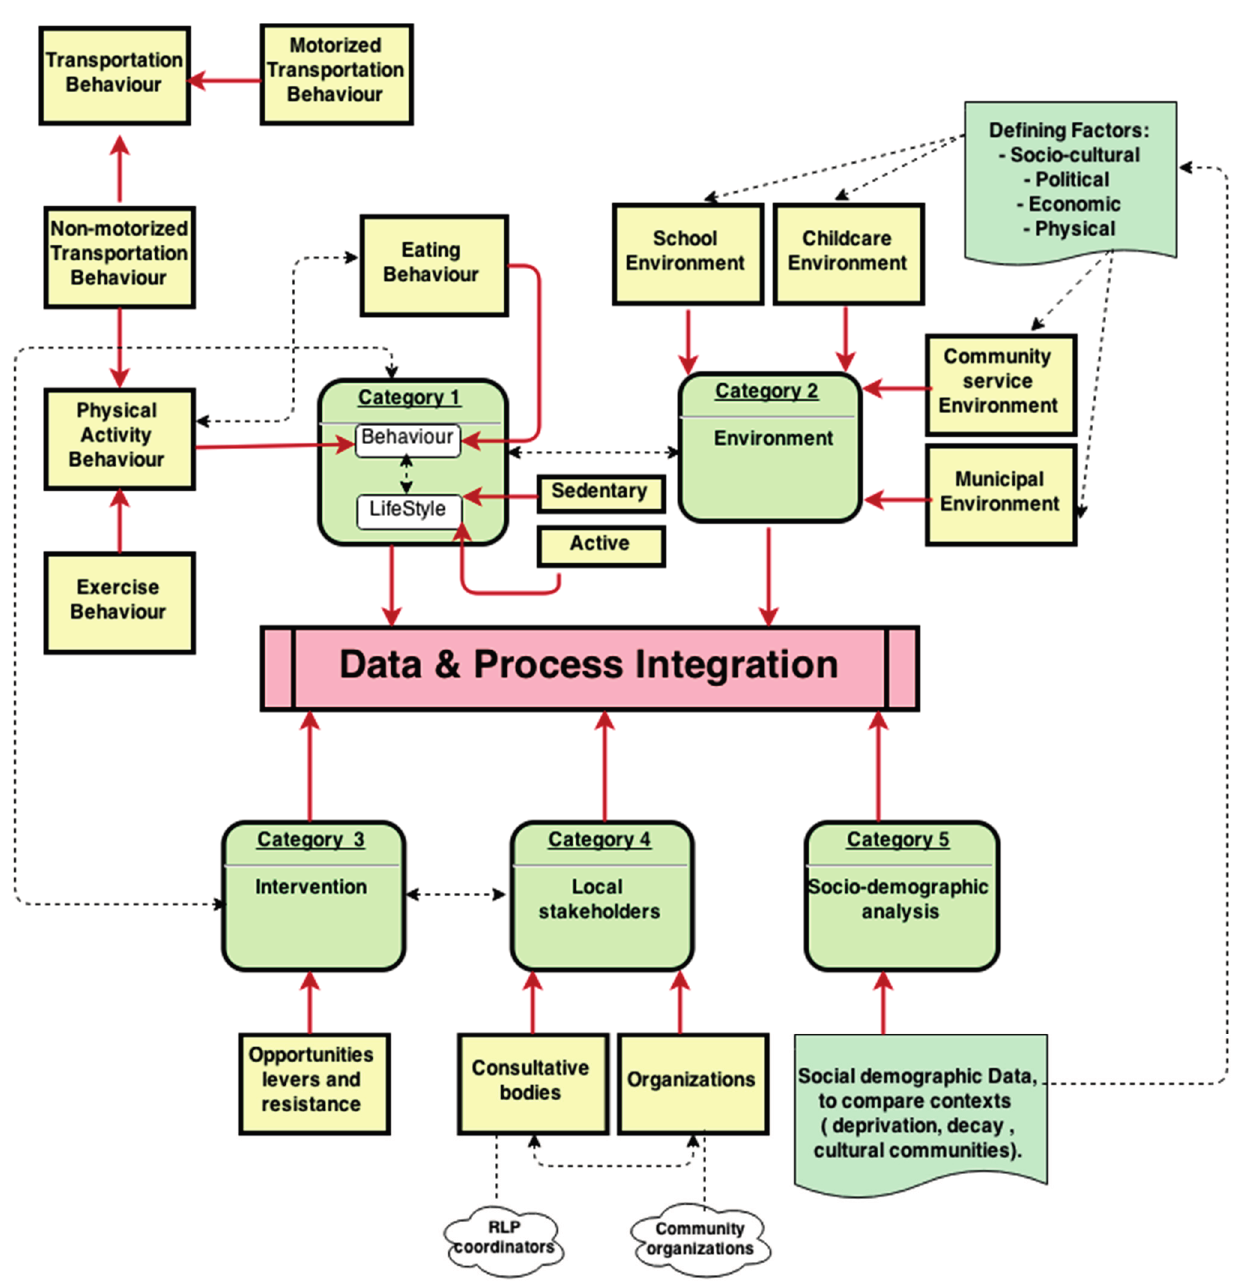
Figure 4. Data Integration—Mapping of QEF data for community networks (based on QEF Evaluation